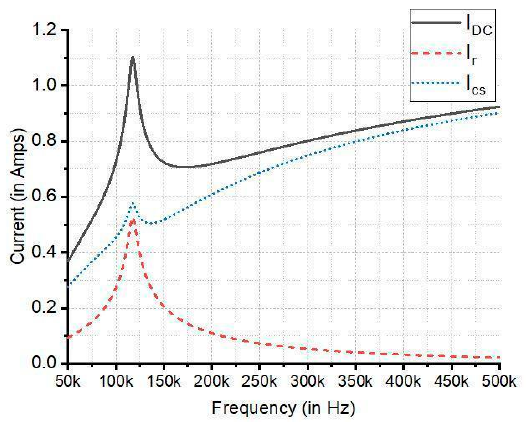
Figure 7. Variation of current through input side, MOSFET, and resonant network with respect to the frequency.